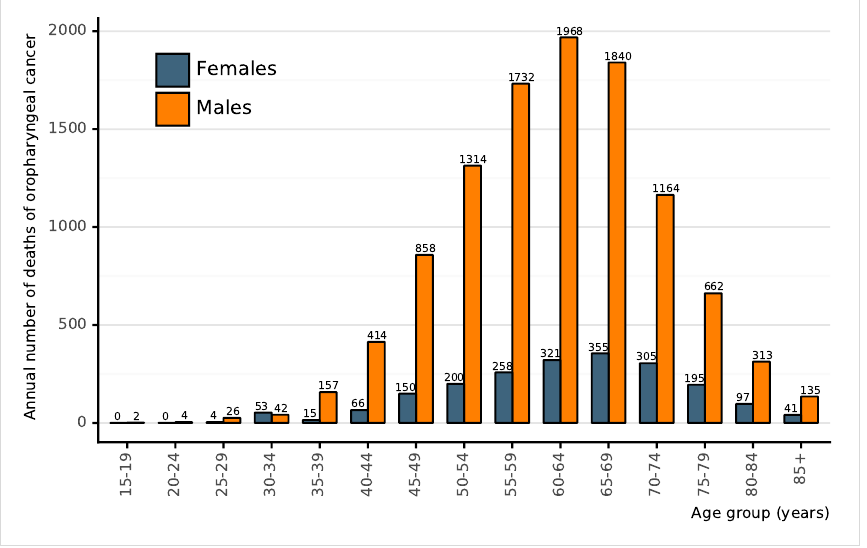
Figure 39: Annual number of deaths of oropharyngeal cancer in India (estimates for